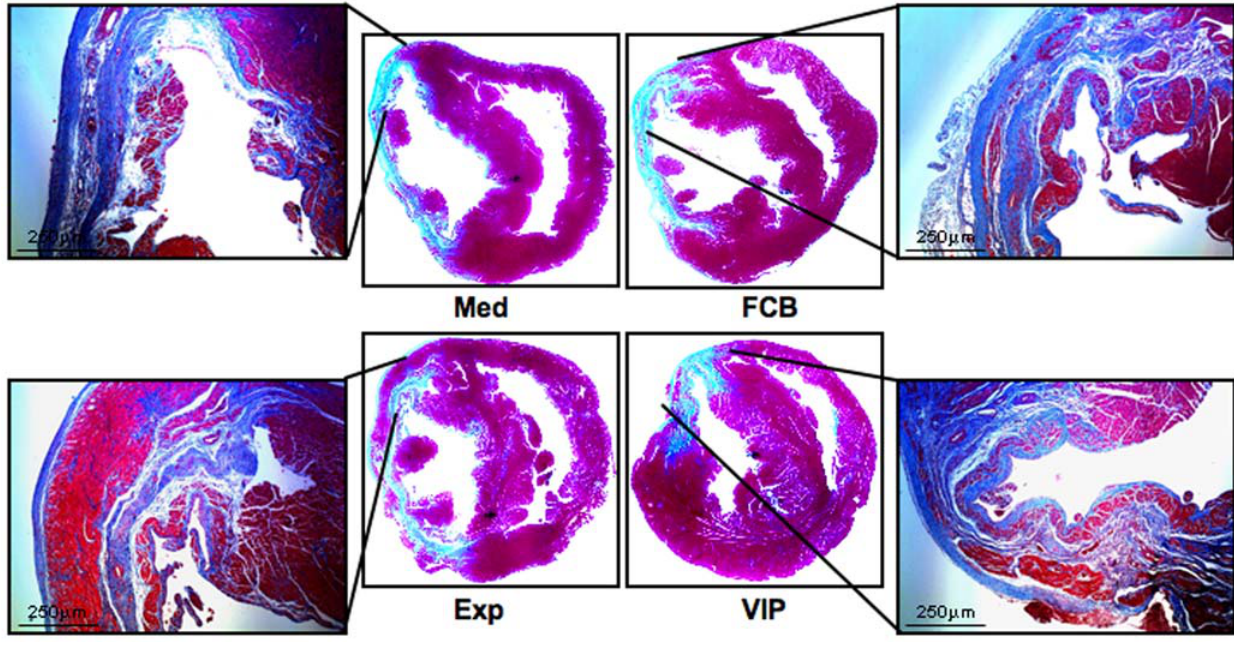
Figure 1. Evaluation of total ischemic area using Masson’s trichrome staining. Paraffin-blocked tissues from infarct zones were sectioned and stained with Masson’s trichrome after six weeks of therapy demonstrating decreased infarct size in VIP , Exp , FCB , Med groups. Five sections were examined from each heart. Four hearts from each group were evaluated. Every section was examined with low power field to visualize gross heart morphology, and to visualize fibrous tissues after ischemia, and area of interest of each heart section is magnified. Representative gross heart pictures are shown here with areas of interest in higher magnification.